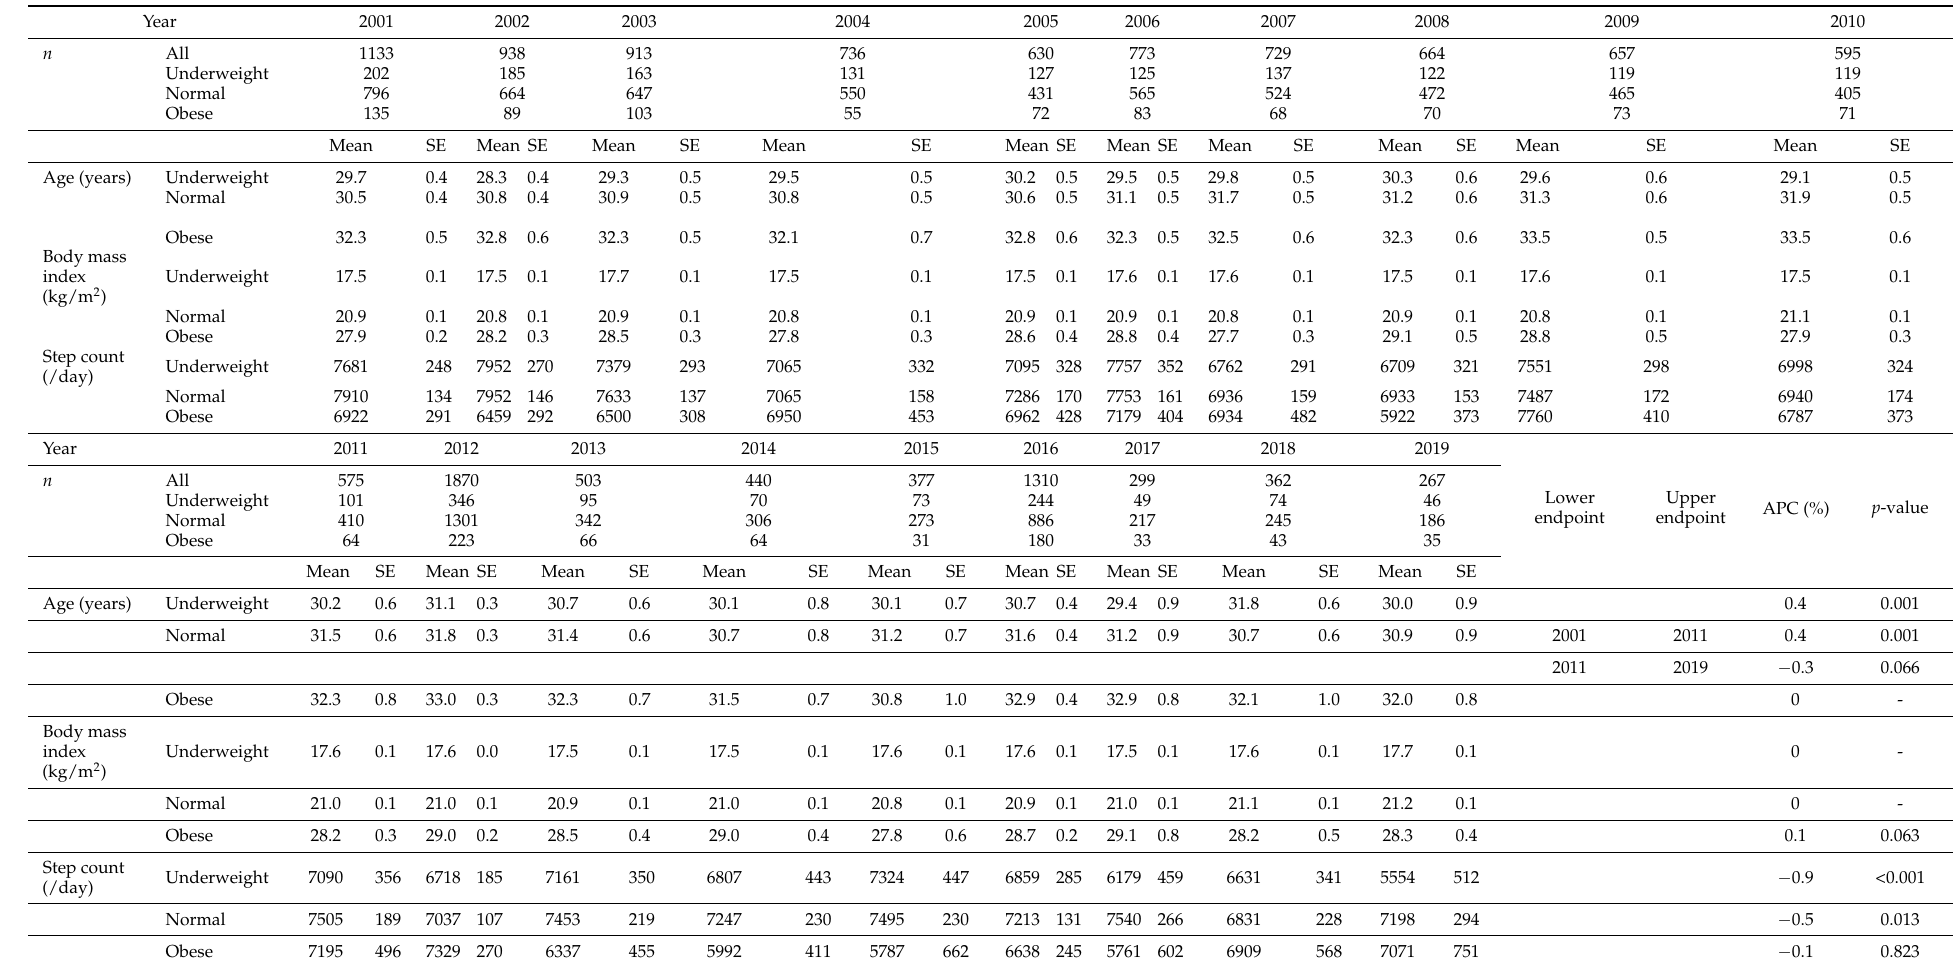
Table 1. Characteristics of Japanese women aged 20–39 years in the 2001–2019 National Health and Nutrition